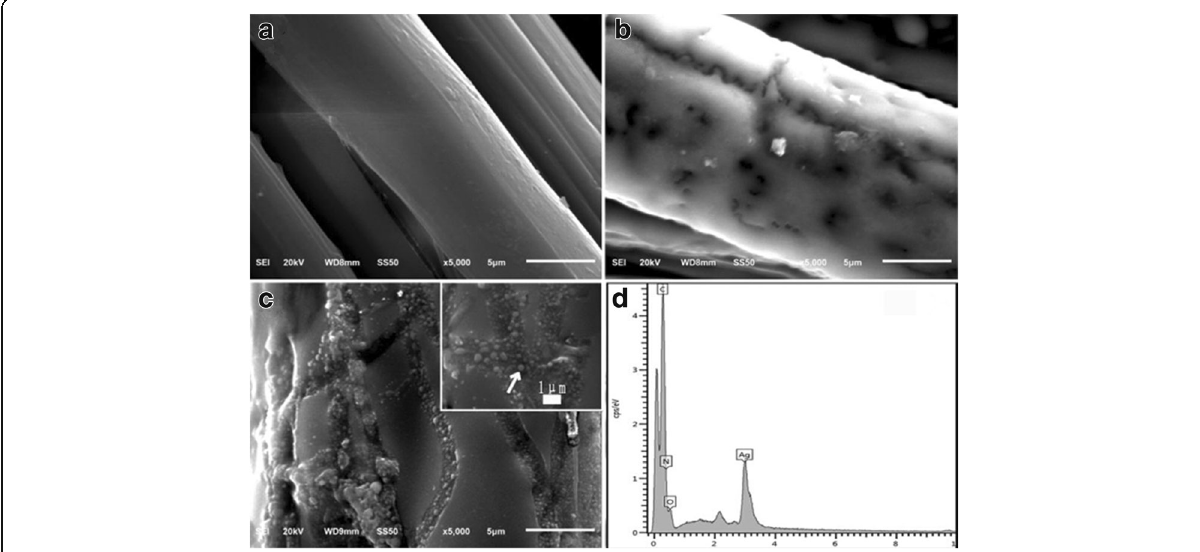
Fig. 13 Surface morphologies of pristine silk fiber ( a ), (PAA/PDDA)8 film-coated silk fiber ( b ), and AgNPs-(PAA/PDDA)8 film-coated silk fiber ( c ). Inset: SEM image with higher magnification. ( d ) EDS spectrum of AgNPs-(PAA/PDDA)8 film-coated silk. The arrow indicates the